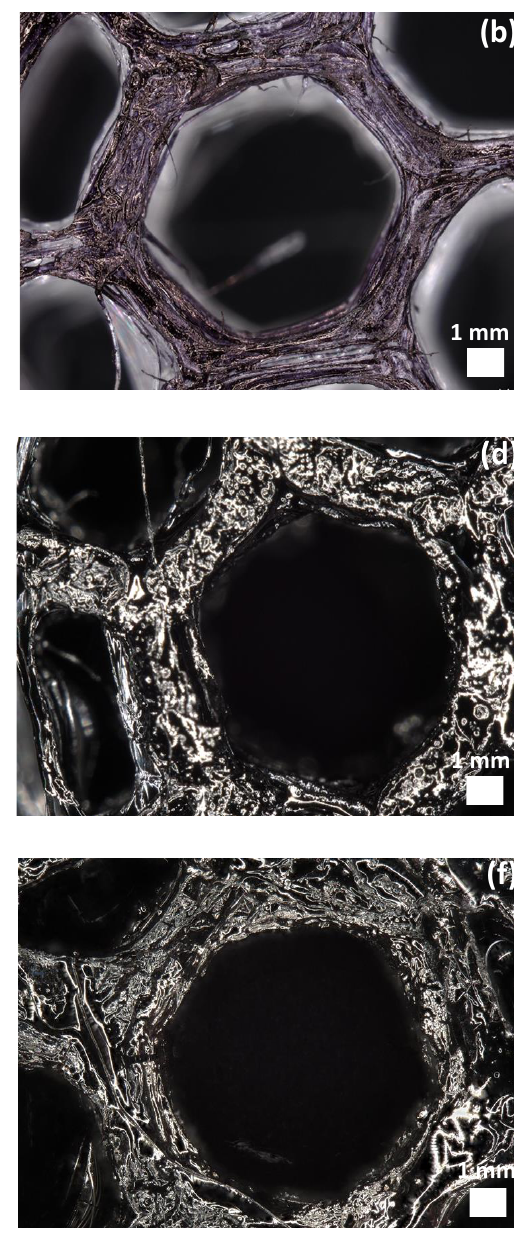
Figure 3. 3D Optical microscopy images of ( a , b ) PLA 3D cellular structure. ( c , d ) 3D SiCN. ( e , f ) 3D SiC.